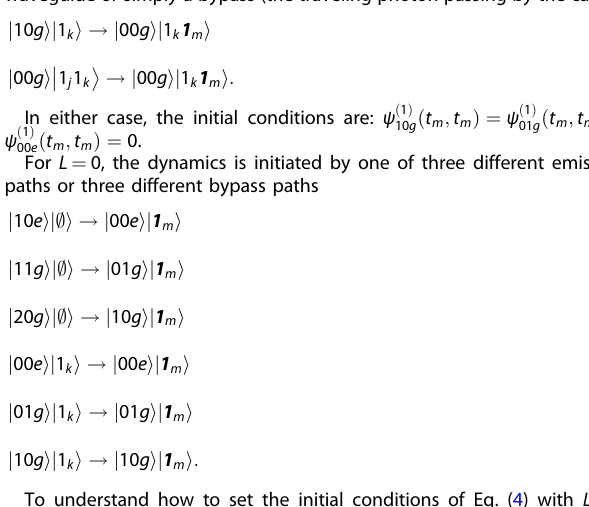
Fig. 3 Photonic integrated circuit implementation of a controlled- phase gate. The gate acts on two dual-rail qubits encoded in four waveguides. The top two waveguides serve to encode one qubit. The logical state of that qubit depends on which of the waveguides contains a photon, as labeled on their left end. All four waveguides are terminated by identical one-sided cavities depicted in Fig. 1a. The “ 0 ” -arm cavities preserve the relative timing of the photon pulses and need not contain TLEs. The “ 1 ” -arm cavities perform the nonlinear phase shift and must contain identical TLEs. A 50/50 beamsplitter between the “ 1 ” -arms cause the transformation 1 w 1 w j i þ 0 w 2 w j iÞ resulting in two photons arriving at one of the TLE cavities if the logical state of the qubits is 11 j i (i.e., a photon in each of the middle two waveguides.). The cavity control is such that they map 1 w j i7! 1 w j i , but 2 w j i7! (cid:5) 2 w j i . This extra phase is the crucial component enabling our controlled-phase gate. We use the w subscript to denote physical photon in a waveguide, to avoid confusion with the notation used for the logical states of the dual-rail